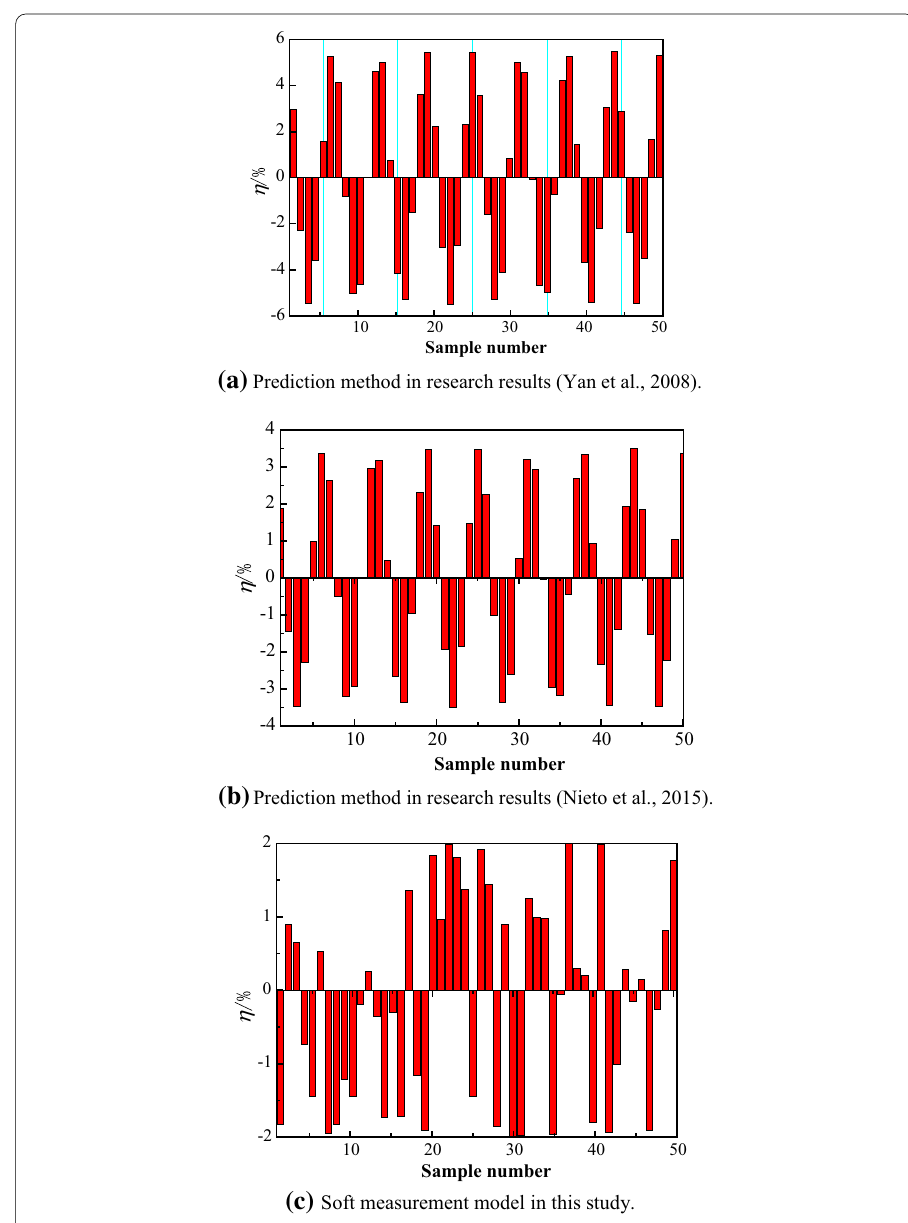
Fig. 4 Comparison of relative error between the calculated and actual